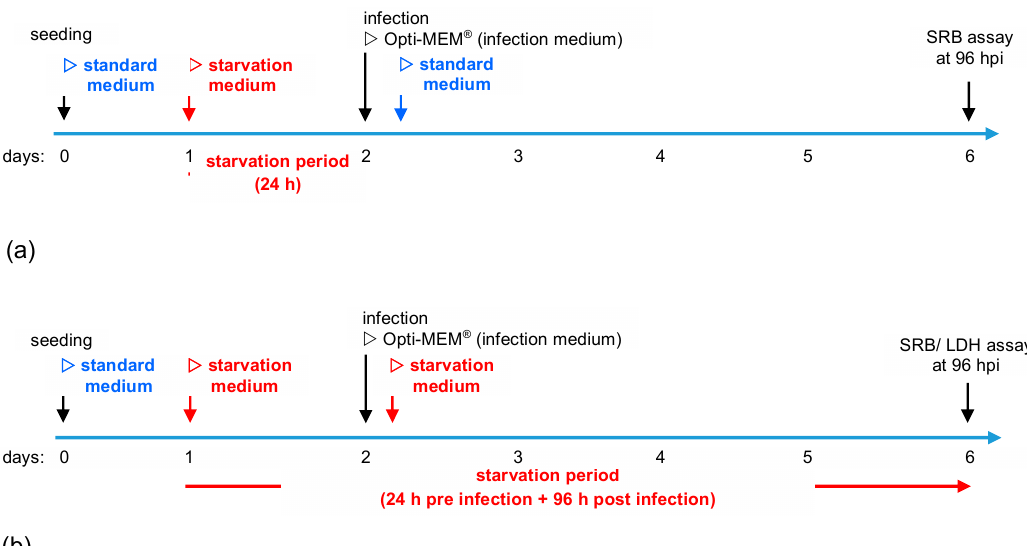
Figure 1. Illustration of starvation conditions. ( a ) Short-term starvation: Cells were seeded in standard medium. On day 1, medium was changed to starvation medium (i.e., starvation medium with variations in contents of glucose and fetal calf serum (FCS)). On day 2, infection with MeV was performed in infection medium (Opti-MEM ® ). At 3 h post-infection (hpi), infection medium was replaced with standard medium. At 96 hpi, the remaining tumor cell masses were determined by the sulforhodamine B (SRB) assay. ( b ) Long-term starvation: Cells were seeded in standard medium on day 0. Medium was changed to starvation medium on day 1. The 3 hpi, infection medium was replaced with the respective starvation medium. At 96 hpi, the remaining tumor cell masses were determined by SRB or lactate dehydrogenase (LDH) assay.